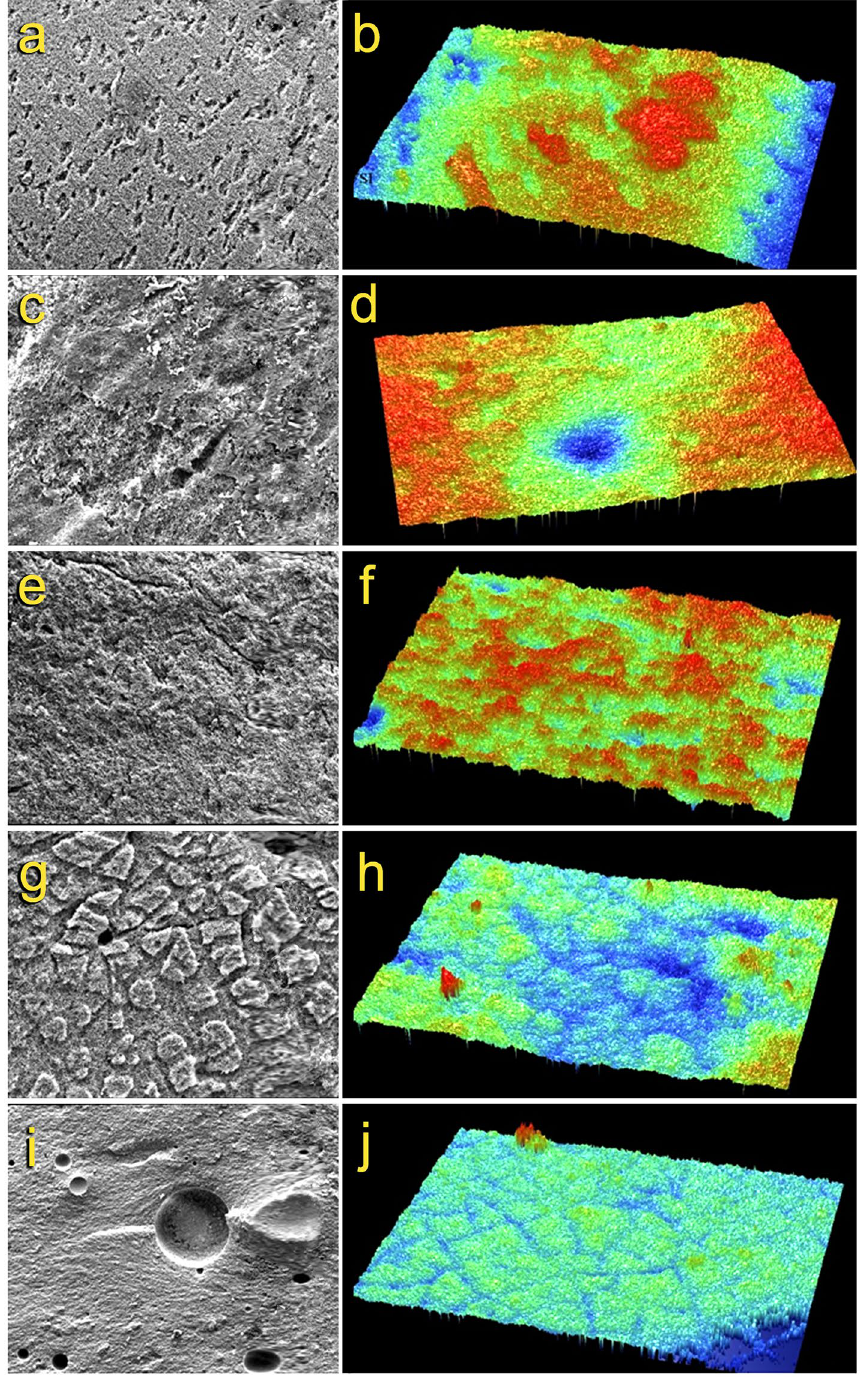
Figure 3. Scanning electron microscopy (SEM; left column) and 3-D profilometry images (20.5 × ; right column) of lithium disilicate specimens after different surface treatments. ( a) SEM (1000 × ) and ( b ) profilometry images of the hydrofluoric acid-etched control group. ( c ) SEM (1000 × ) and ( d ) profilometry images of the Er:YAG laser group. ( e ) SEM (1000 × ) and ( f ) profilometry images of the Graphite + Er:YAG laser group. ( g ) SEM (1000 × ) and ( h ) profilometry images of the Nd:YAG laser group. ( i ) SEM (500 × ) and ( j ) profilometry images of the Graphite + Nd:YAG laser group. The lower SEM magnification enabled visualization of the craters scattered across the treated ceramic